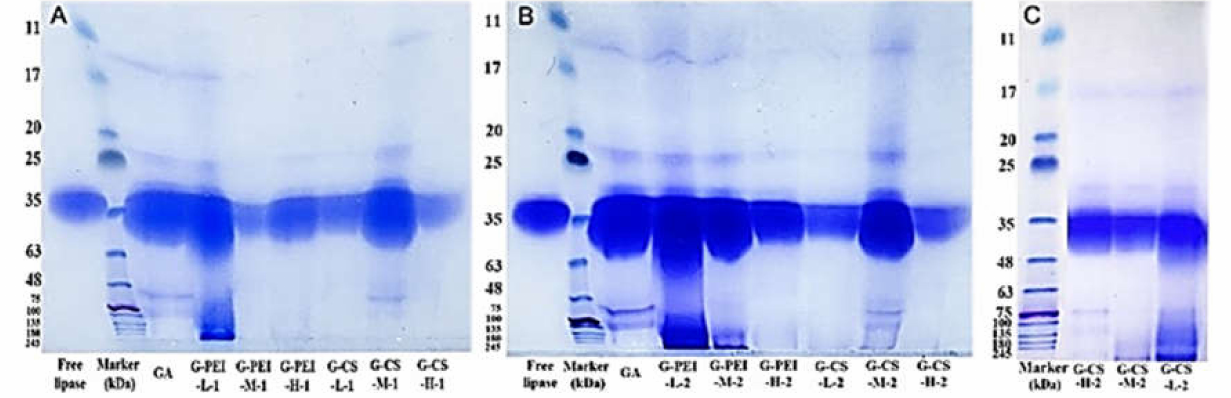
Figure 4. The crosslinked products analyzed via SDS-PAGE were described in ( A – C ). Different letters indicate statistically significant differences. Certain lanes were deleted from G due to the experi- mental mistakes in sample loading. Its original SDS-PAGE is shown in the Supplementary Materials (Figure